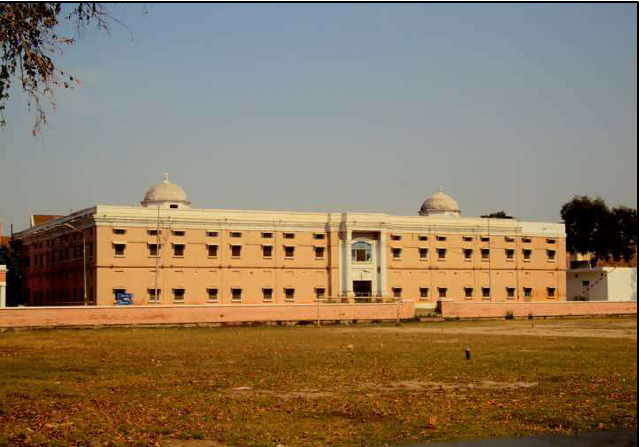
Figure 17. Elevation view of Umar Hall, a 100-year-old building.